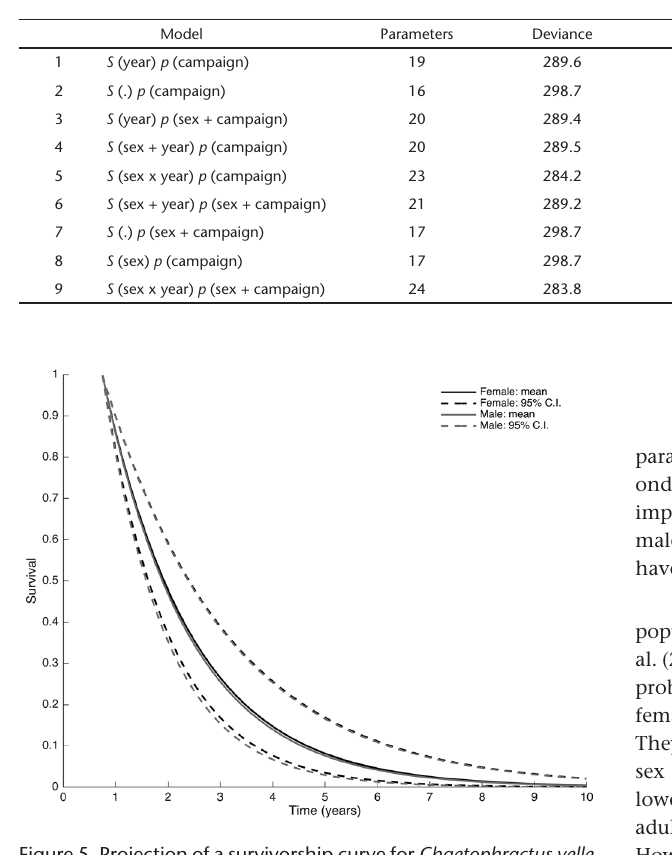
Figure 5. Projection of a survivorship curve for Chaetophractus velle- rosus adult individuals of both sexes, assuming constant survival, from an age of nine months old, when sex maturity is achieved (Nowak 1991), to 10 years old. Solid lines correspond to mean and dotted lines correspond to 95% confidence intervals (black = female, grey =